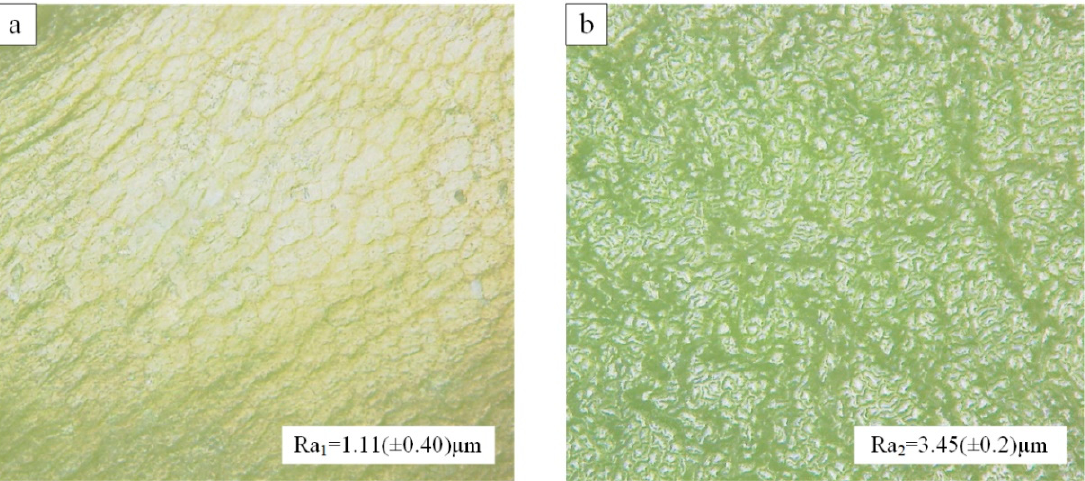
Figure 3. Surfaces of fresh bud ( a ) and young leaf ( b ) with 400× magnification observed by 3D laser scanning microscope.